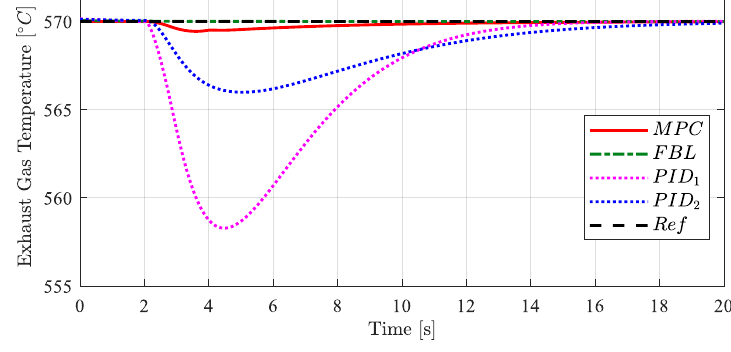
Figure 10. Power production time profile.